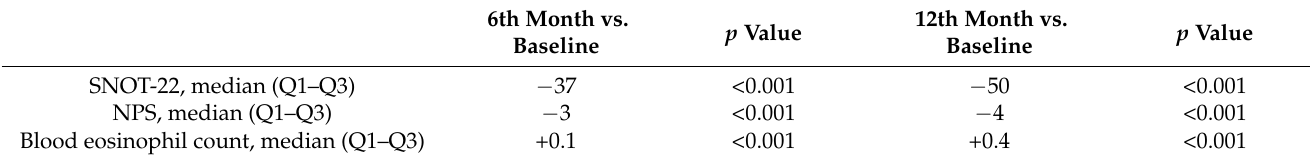
Table 2. Differences from baseline to each follow-up for SNOT-22, NPS and blood eosinophil count. 6th Month